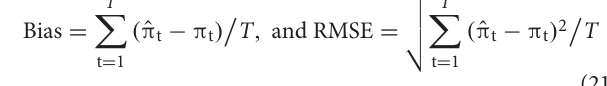
(Bürkner et al., 2019). The real-world correlation matrix is [1,